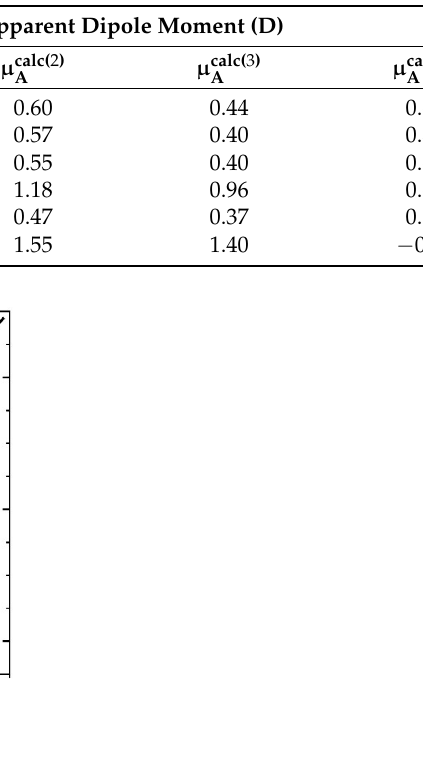
( 4 ) Figure 5 . Predicted μ (cid:2885)(cid:2913)(cid:2911)(cid:2922)(cid:2913)((cid:2872)) versus experimental μ (cid:2885)(cid:2915)(cid:2934)(cid:2926) values for the studied phosphatidylcholines Figure 5. Predicted µ calc versus experimental µ exp values for the studied phosphatidylcholines A A with the line of identity. with the line of